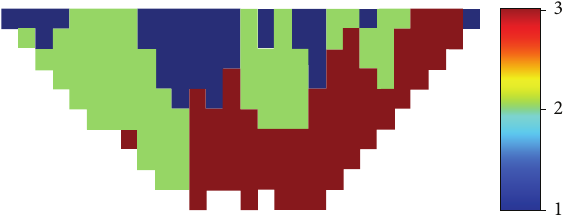
Figure 2: A three-period infeasible solution (in terms of the required slope angles) generated by the proposed PSO algorithm during the iterative process.